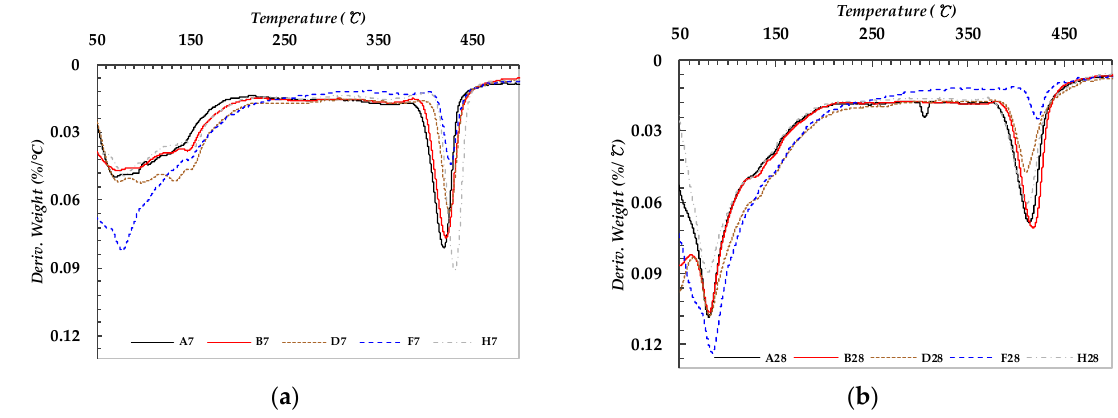
Figure 3. Derivative thermogravimetry (DTG) result of ( a ) 7 d and ( b ) 28 d cured specimens.